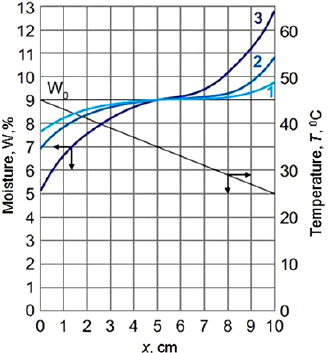
Fig. 2. A characteristic moisture content profile and the established distribution of temperature T on length of a sample x at initial humidity of W 0 = 15%. Time from the beginning of experience, h: 1–4; 2–7; 3–20